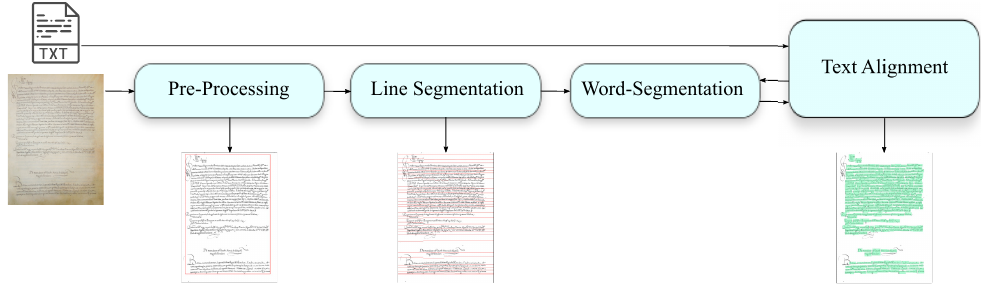
Figure 2. The workflow of the entire process: The input consists of the colour image of a document and its transcription. The document is pre-processed by creating its black and white version and identifying the text area. Then follows the segmentation into lines of text and finally the alignment of the